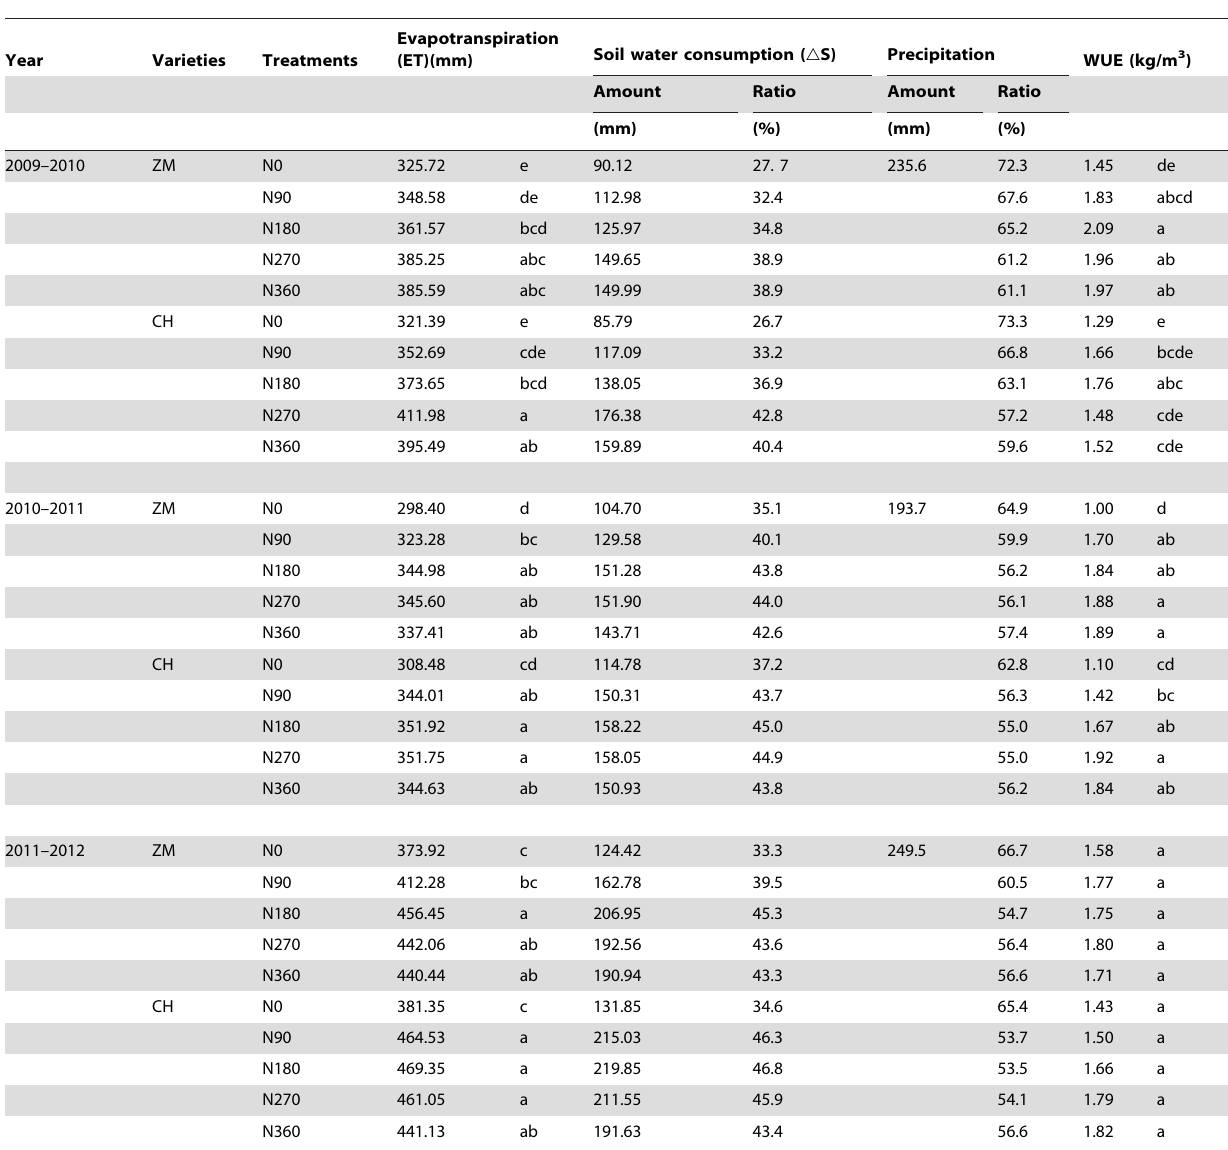
Table 2. Water consumption from soil ( D S) or precipitation and its ratio to total evapotranspiration (ET) and WUE.